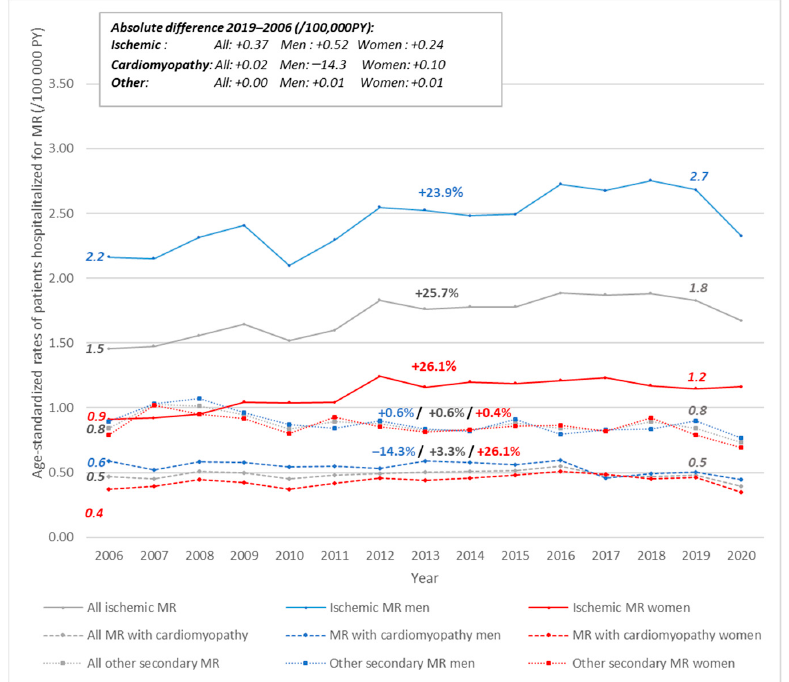
Figure 3. Trends in age-standardized rates of patients hospitalized for secondary mitral regurgitation in person-years, according to etiology and sex, France, 2006–2020. The percentage above the curve is the relative rate difference between 2019 and 2006. PY = person-years.